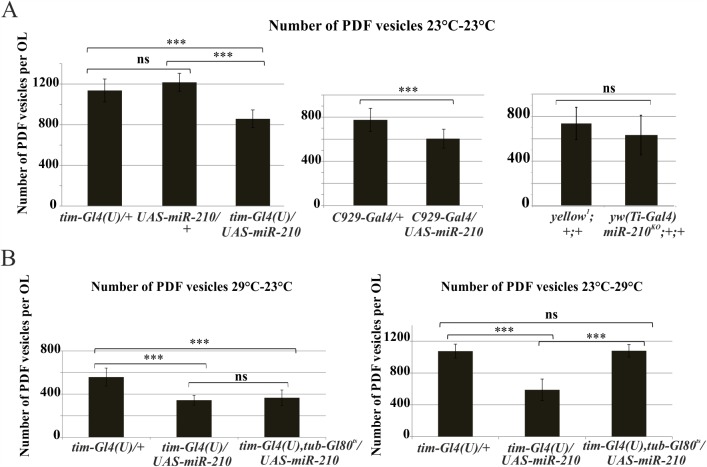
PDF vesicles quantification in the optic lobe.(A) Number of PDF vesicles in (A) miR-210 over-expressing flies (tim-Gl4(U)/UAS-miR-210 and C929-Gal4/UAS-miR-210) and yw(Ti-Gal4)miR-210
KO;+/+, compared to their controls (tim-Gl4(U)/+, UAS-miR-210/+, C929-Gal4/+ and yellow1;+/+), and (B) in flies with miR-210 over-expression (tim-Gl4(U),tub-Gl80ts/UAS-miR-210/+) restricted only during development (29°C-23°C), or only during adulthood (23°C-29°C), with respect to positive (constitutive over-expression, tim-Gl4(U)/UAS-miR-210) and negative (tim-Gl4(U)/+) controls. Flies were dissected at ZT0. Over-expression was modulated by using the Gal4-Gal80ts-UAS ternary system. Mean ± SD. t-test: *** p<0.005, ns: not significant.